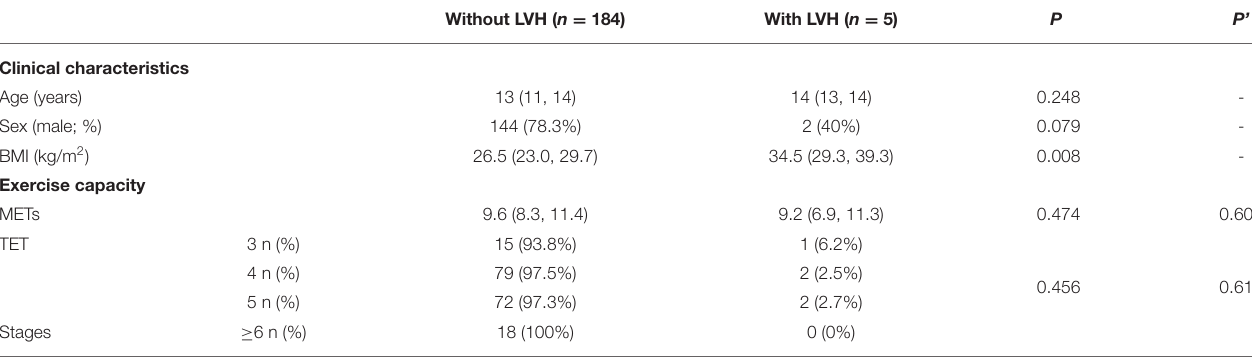
TABLE 4 | Comparison of exercise capacity between patients with and without left ventricular hypertrophy.